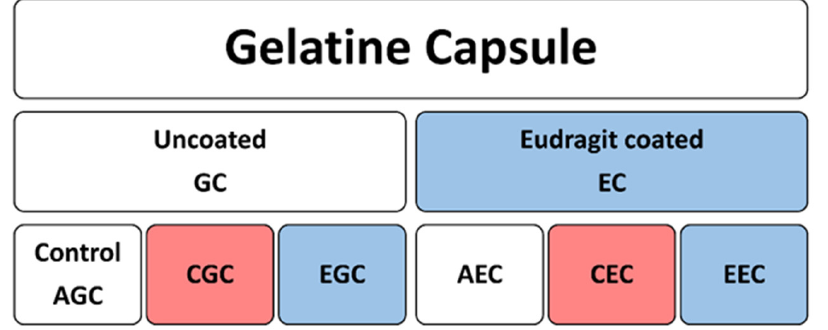
Figure 1. Schematic figure of gelatin capsule samples prepared for the dissolution test. Red color represents chitosan coating, blue represents Eudragit L100-55 coating. GC: uncoated gelatin capsules, EC: Eudragit L100-55 coated gelatin capsules, AGC: uncoated alginate microcapsule filled in uncoated gelatin capsule, CGC: chitosan-coated microcapsule filled in uncoated gelatin capsule, EGC: